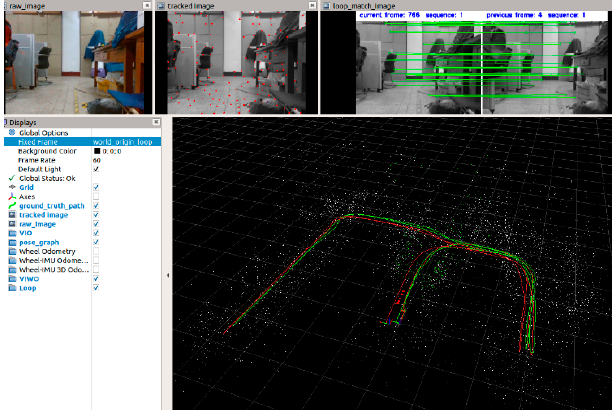
Figure 3. RViz interface at the end of test data playback.